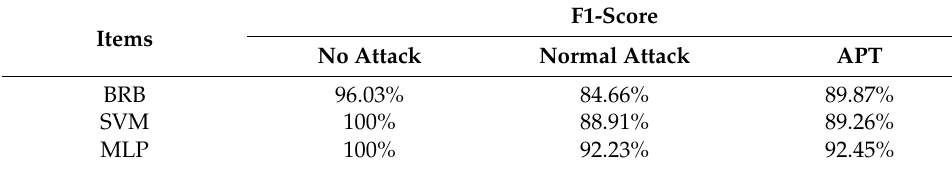
Table 14. The comparison of F1-score.